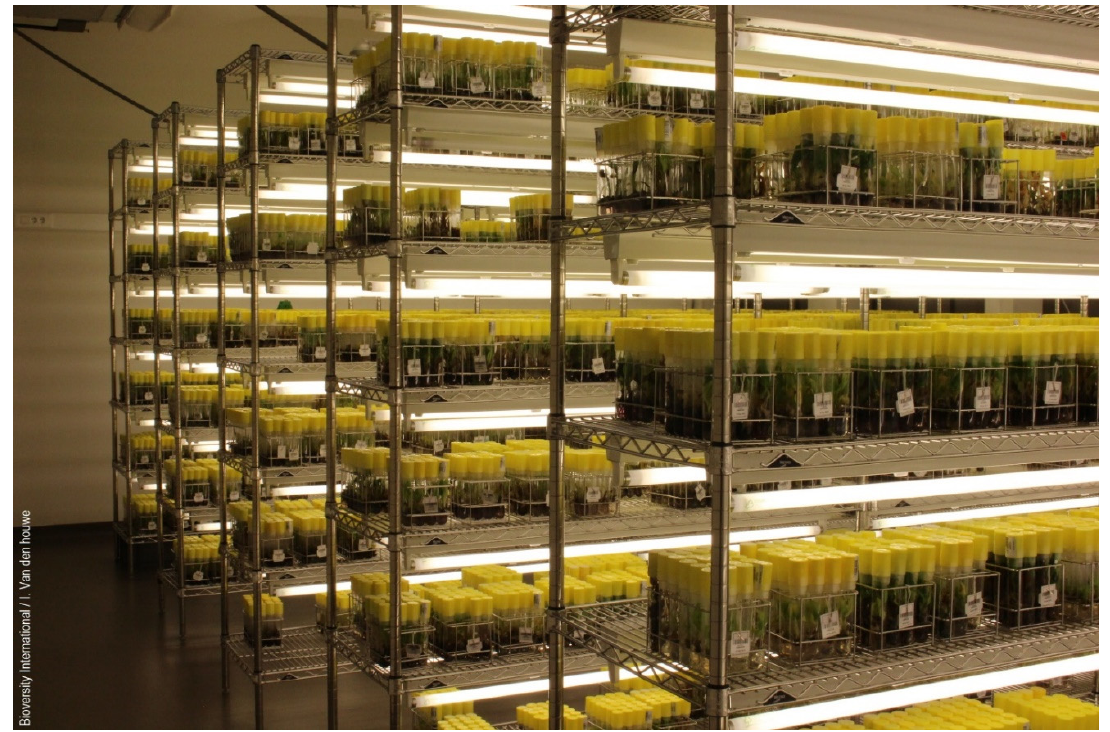
Figure 3. Banana in vitro collection at the International Transit Centre (ITC), Belgium. Box 2. Collection of bananas at the Bioversity Genebank, Belgium.